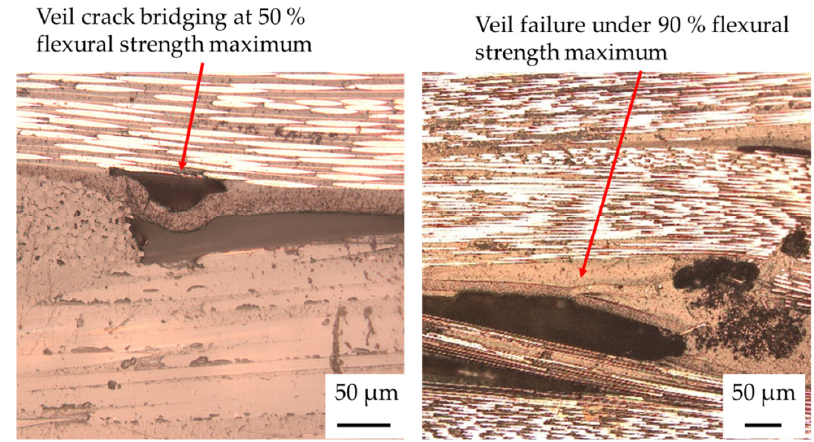
Figure 21. PA 6,6 nanofibre crack bridging in HFT and CFT .